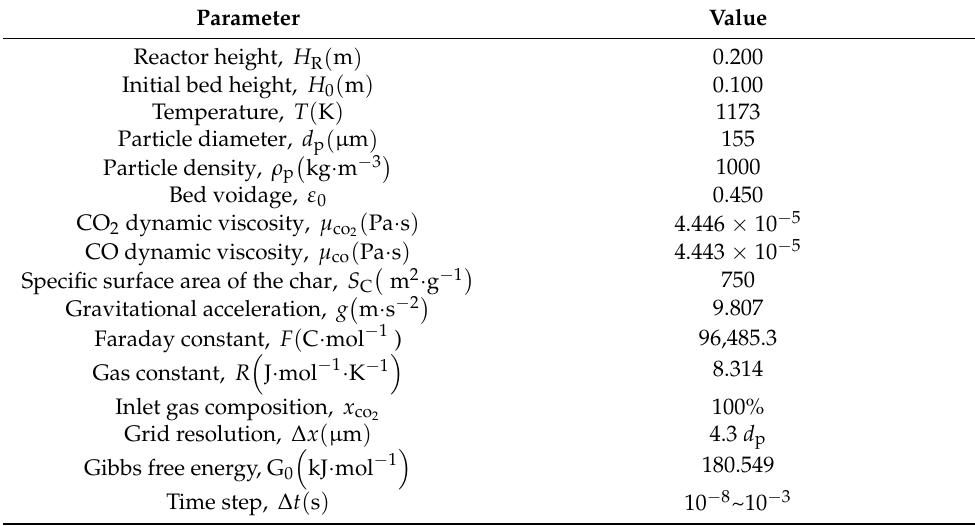
Table 2. Parameters adopted in TFM